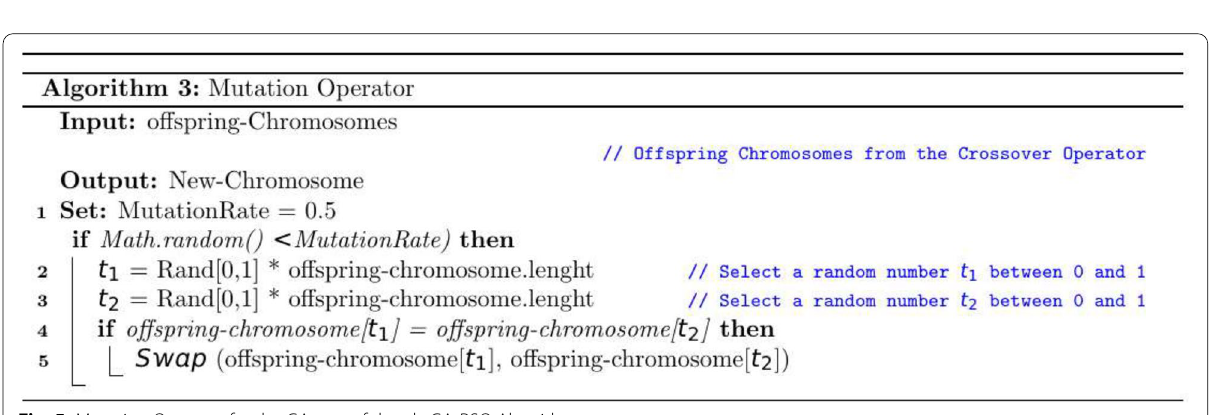
Fig. 5 Mutation Operator for the GA part of the eh-GA-PSO